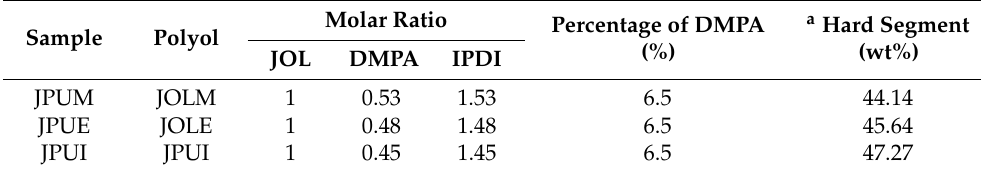
Table 1. The formulation of jatropha-oil-based polyurethane (JPU) dispersions.